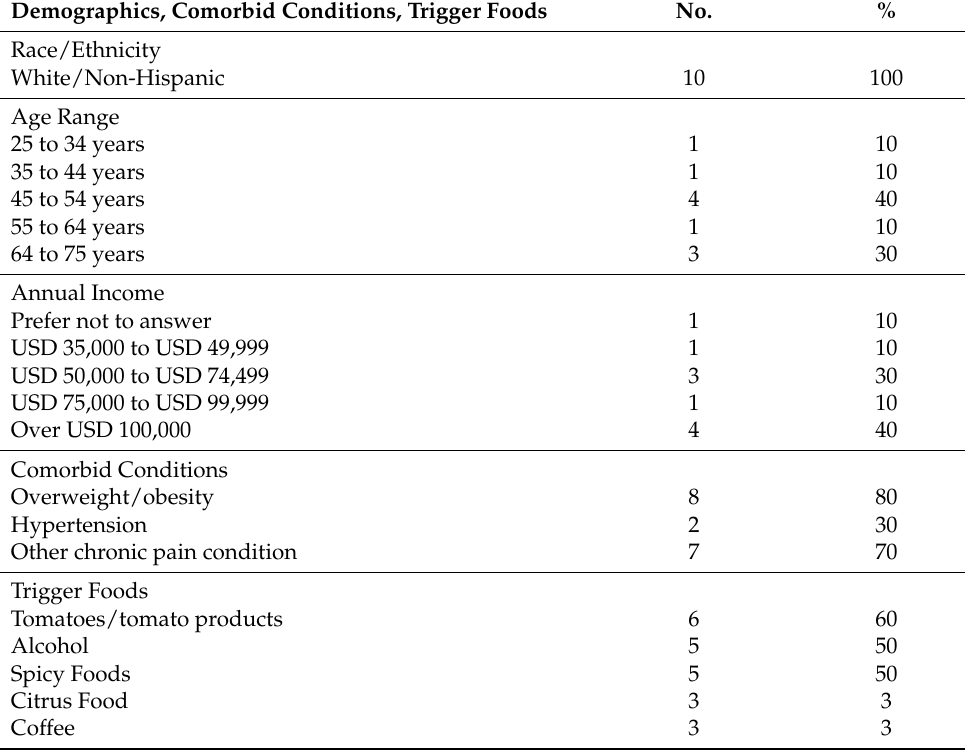
Table 3. Participant demographics, comorbid conditions, and trigger